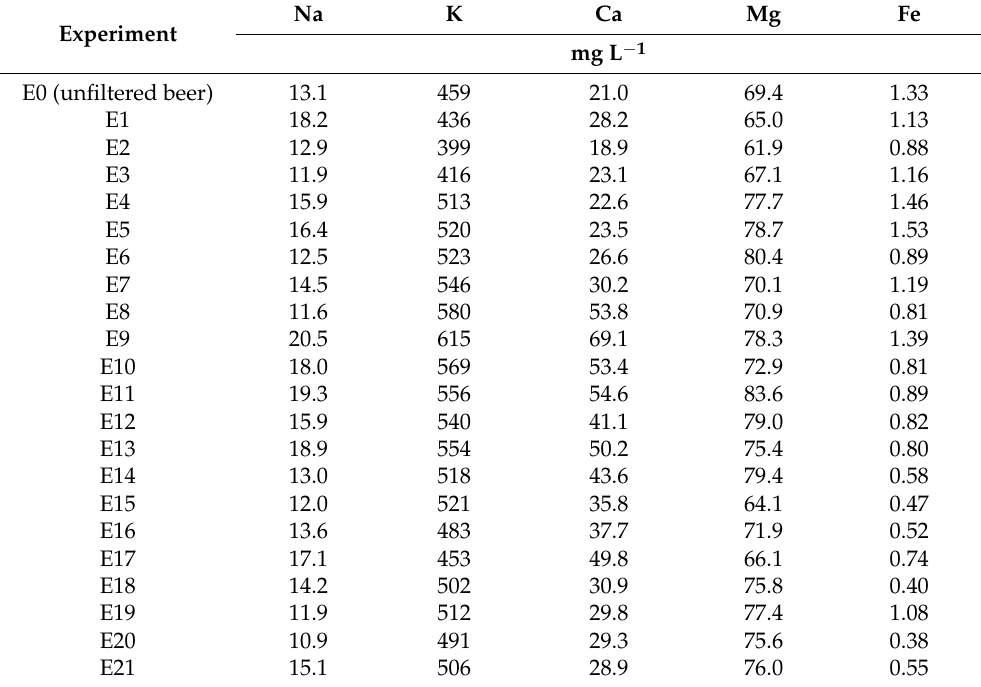
Table 5. Contents of elements (Na, K, Ca, Mg, and Fe) in unfiltered and filtered beer samples measured by